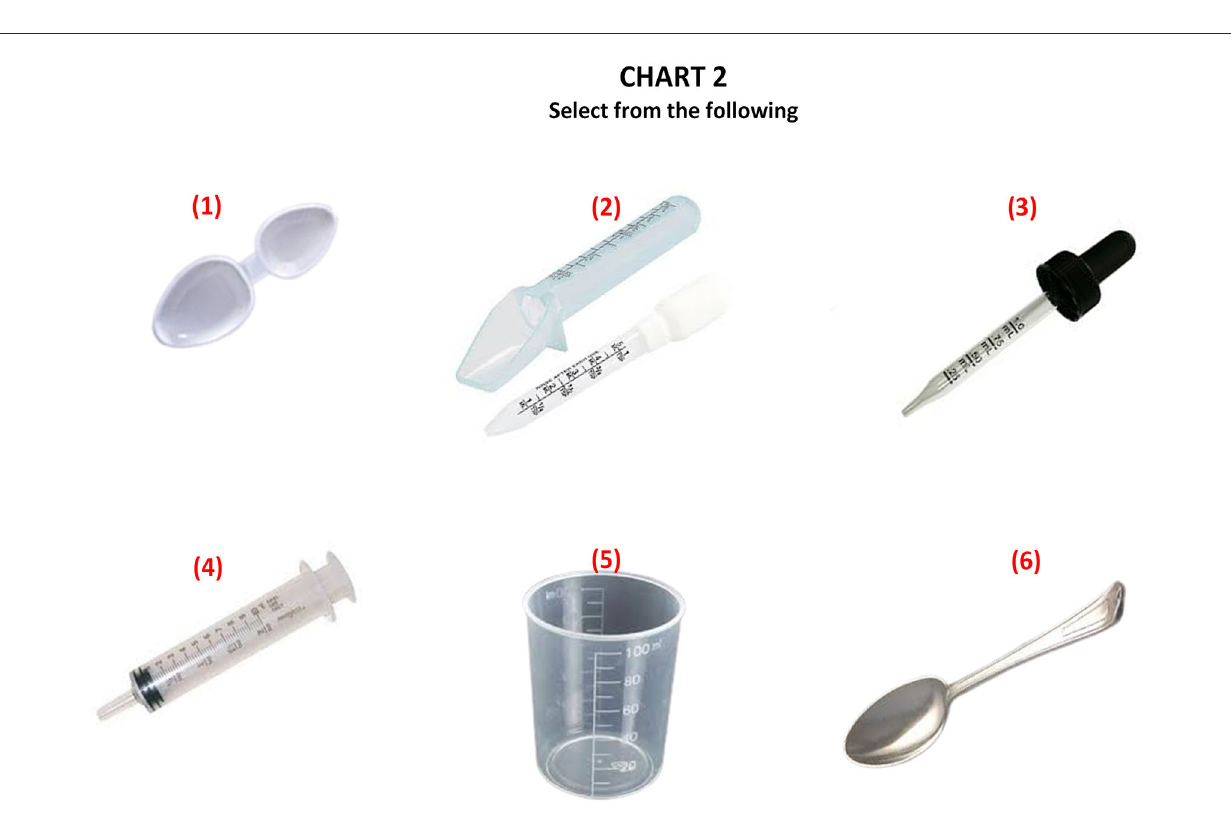
FIGURE2 Different oral liquid medicine administration